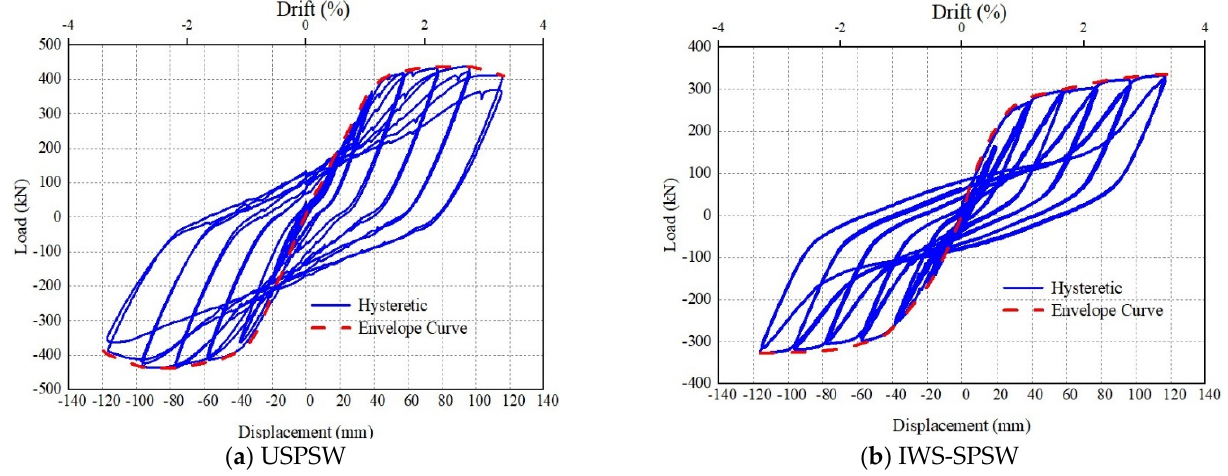
Figure 8. Hysteretic and envelope curves for test specimens .